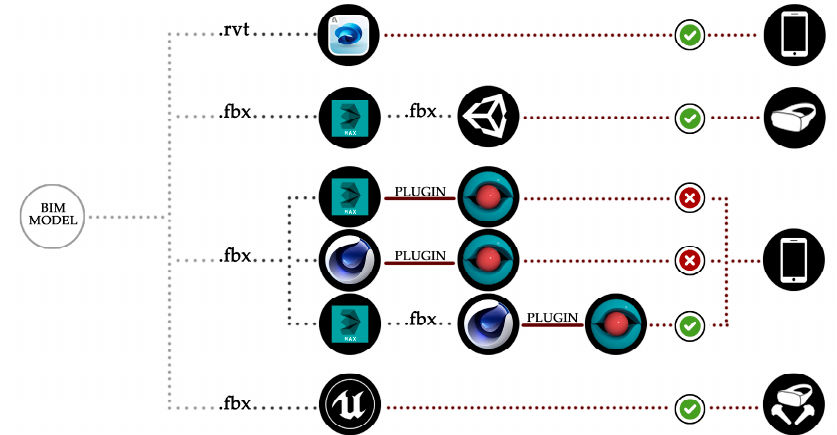
Figure 10. Interoperability tests for data visualization in AR and virtual reality (VR).